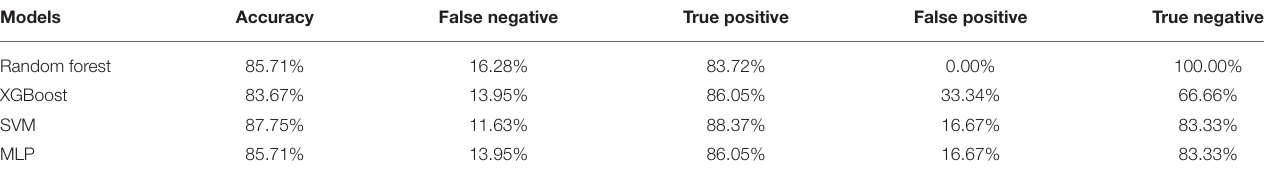
TABLE 3 | Confusion matrix of machine learning models.